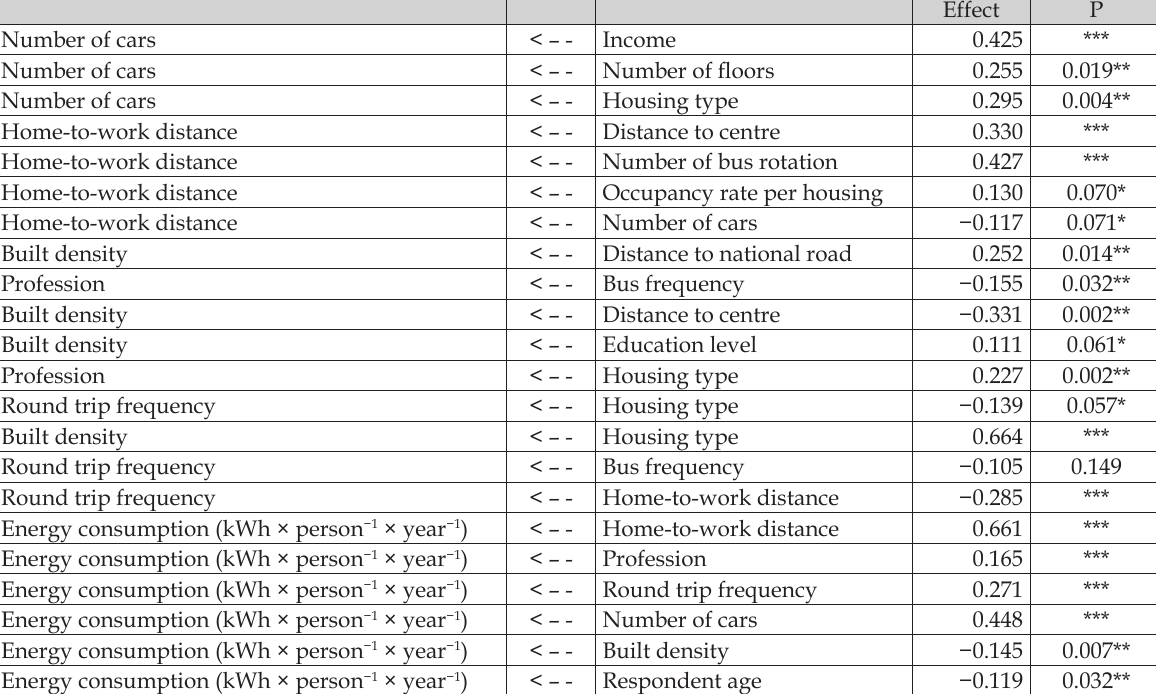
Fig. 6. Direct effects of driving factors explaining the energy consumption generated by commuting. R 2 = 0.61. Source: own Table 6. Direct effects between driving factors.